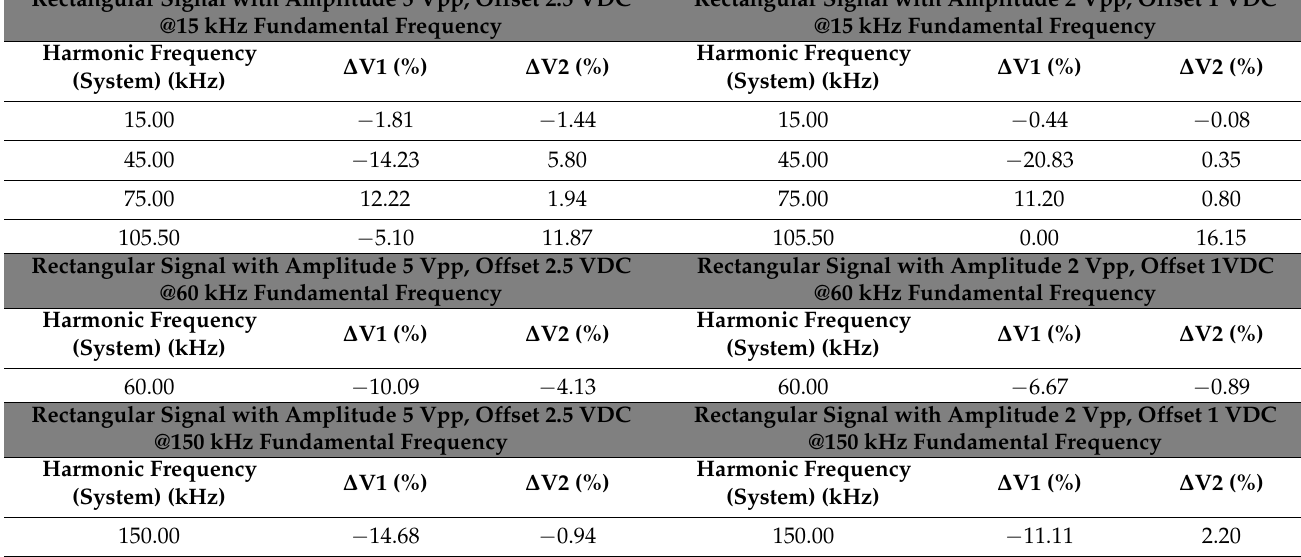
Table 11. The errors that occurred before and after the calibration process. ∆ V1 refers to the error before the calibration. ∆ V2 refers to the error after the